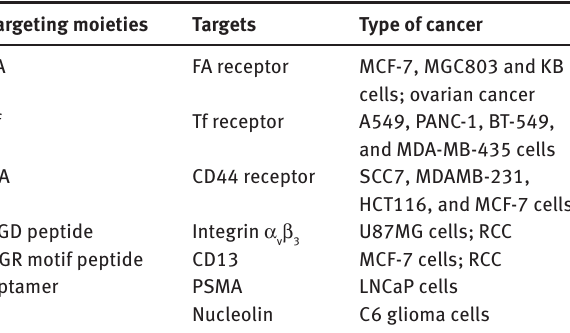
Table 2: Targeting moieties for active tumor targeting.